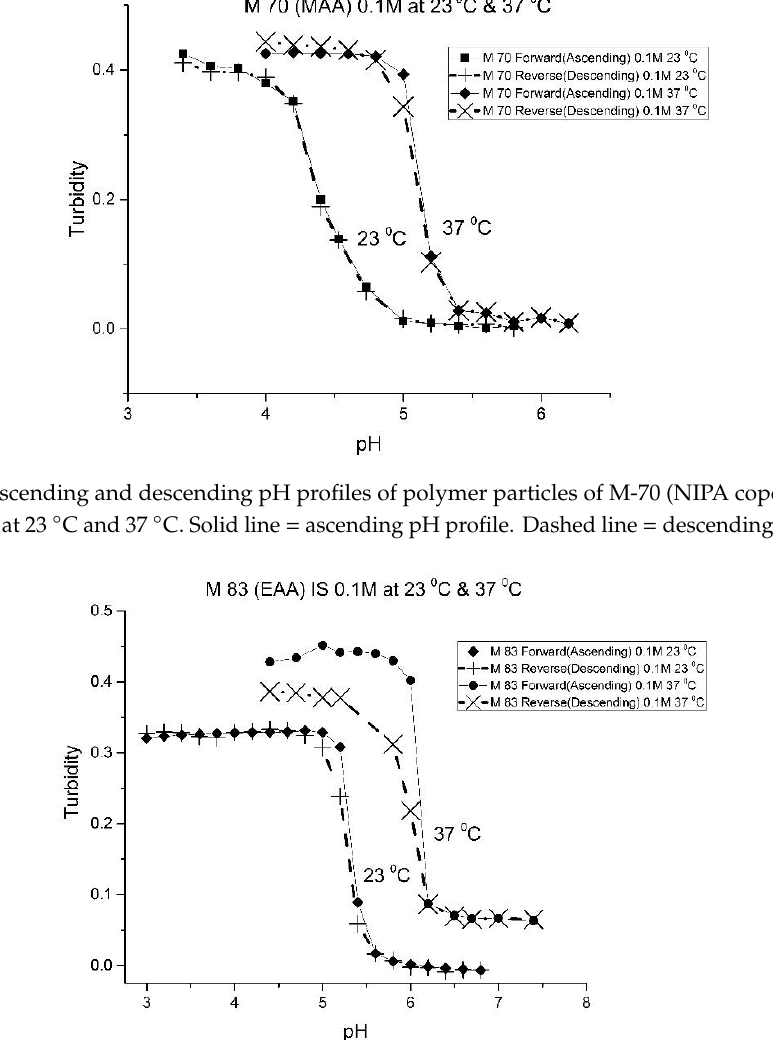
Figure 4. Ascending and descending pH profiles of polymer particles of M-75 (NIPA copolymerized with PAA) at 23 °C and 37 °C. Solid line = ascending pH profile. Dashed line = descending pH profile. Table 1. Formulation of Four Copolymers of N -isopropylacrylamide. Component